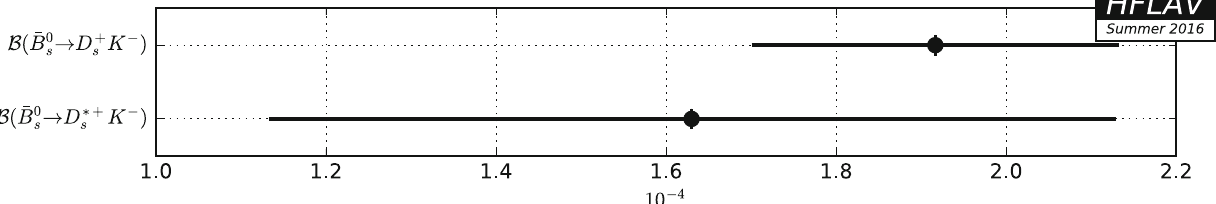
Fig. 153 Summary of the averages from Table 187